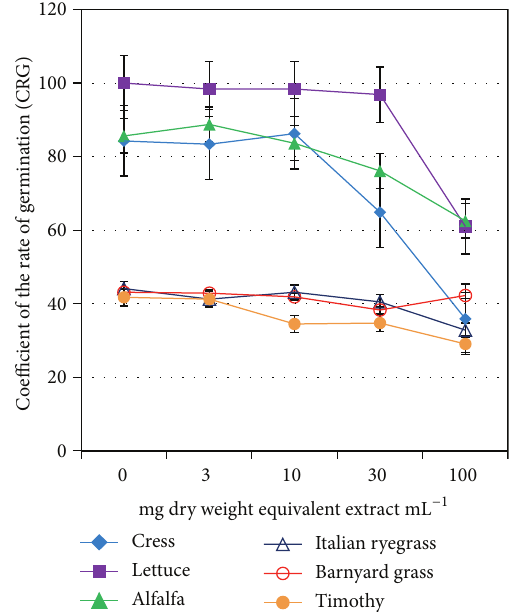
Figure 1: Effect of aqueous methanol extracts of O. tenuiflorum on GP of different plant species at four different concentrations. Con- centrations of tested samples corresponded to the extract obtained from 3, 10, 30, and 100mg dry weight of O. tenuiflorum . Vertical bars represent standard error deviations. Means ± SE from three independent experiments with 10 seedlings for each determination are shown.